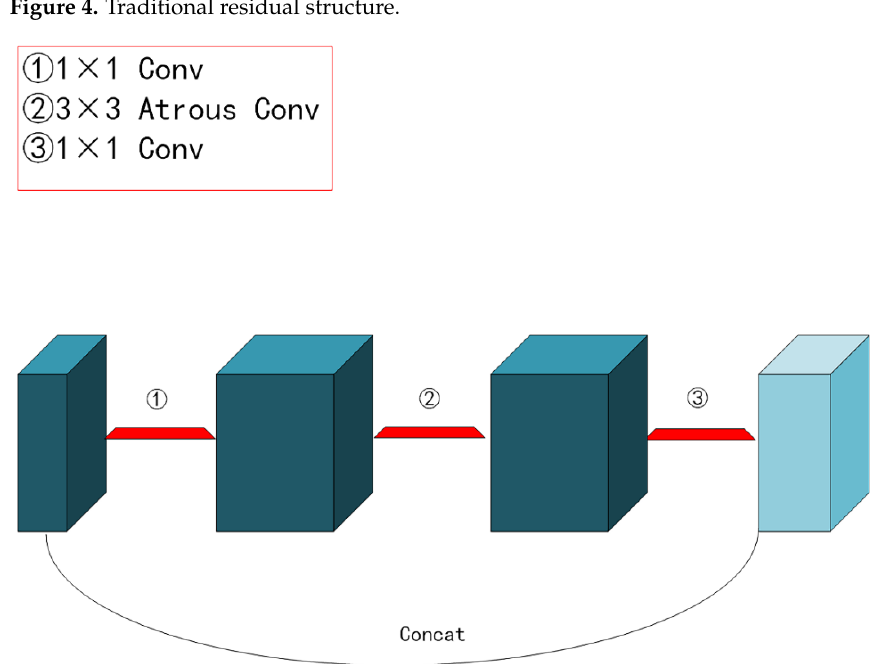
Figure 5. Inverse residual structure.